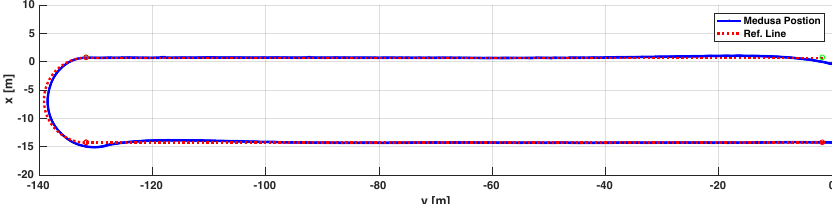
Figure 21. Medusa Vehicle performing lawnmower at Expo Site, Lisbon, Portugal.